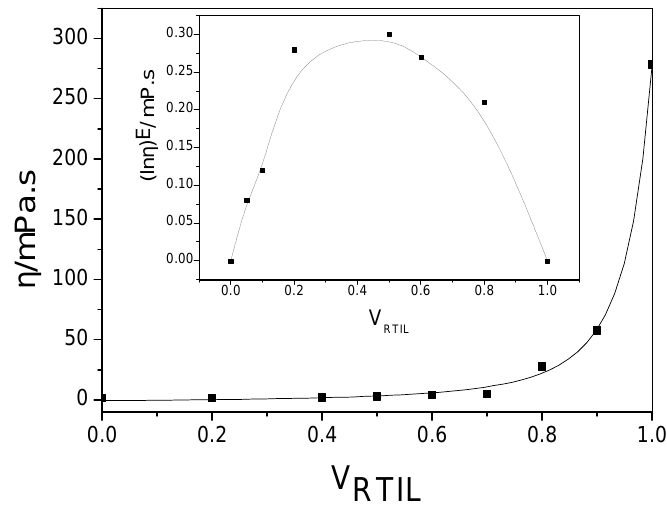
Figure 6. Viscosities of the binary mixture vs. volume fraction of RTIL in RTIL/DMF mixed solvent at 298.15 K. Insert ： The excess logarithm viscosities (ln η ) E for mixtures of [bmim][PF